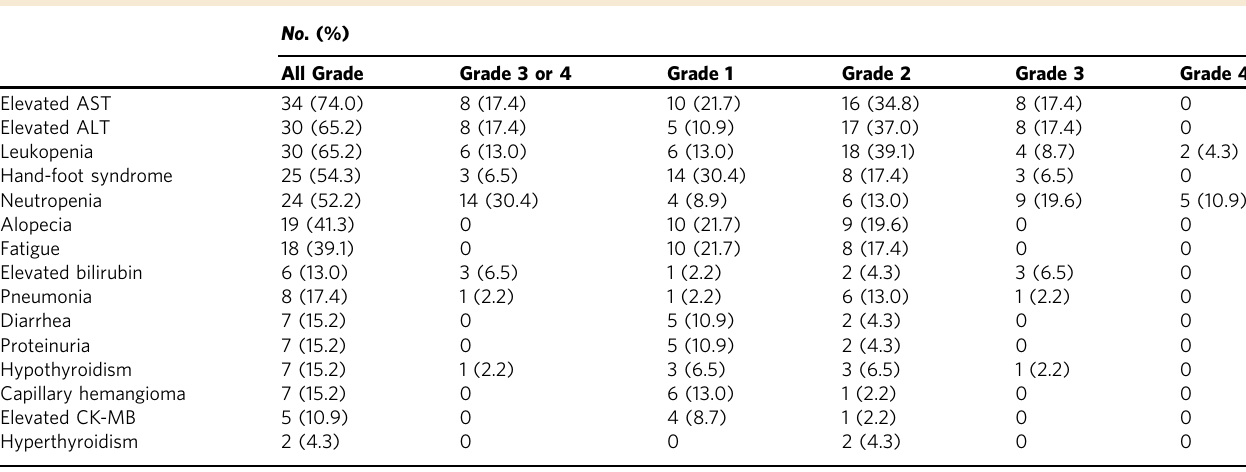
Table 4 Immune-related adverse